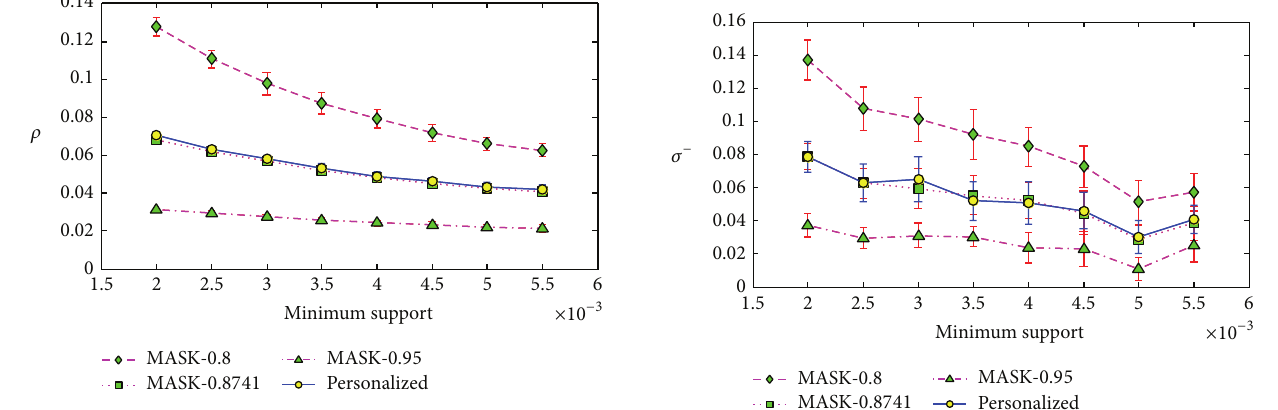
Figure 9: Frequent itemset lost ration 𝜎 − versus minimum support on